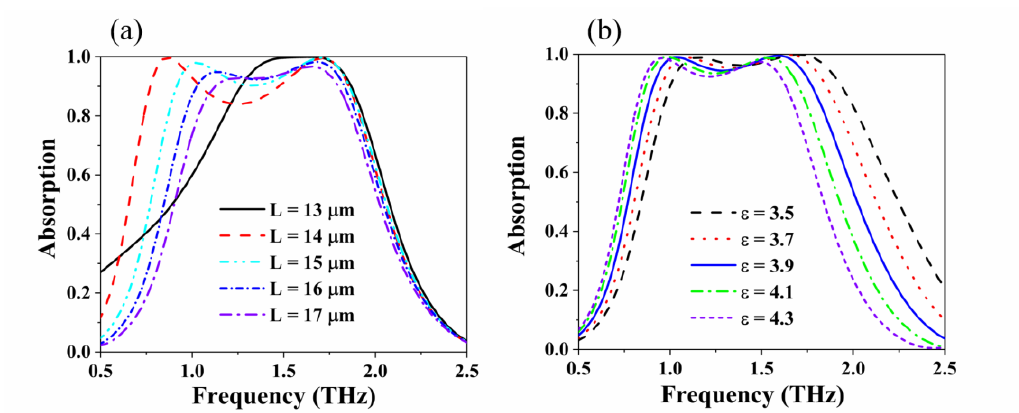
Figure 6. Results of simulating the periodic unit of the structure and relative permittivity of the dielectric layer. ( a ) Influence of the size of the periodic unit ( L ) of the structure on the absorption performance. ( b ) Effect of the relative dielectric constant of the dielectric layer ( ε ) on absorption performance.